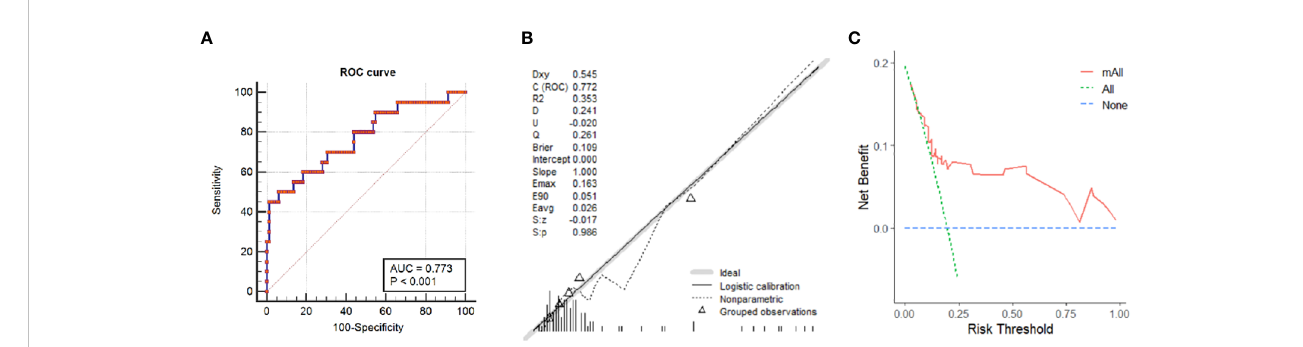
FIGURE 3 Prediction performance of the nomogram. (A) Receiver operating characteristic (ROC) curve of the nomogram. (B) Calibration Curve of the nomogram obtained by comparing the observed and predicted probability in PHPT patients. (C) Decision curve analysis for having MGD in PHPT